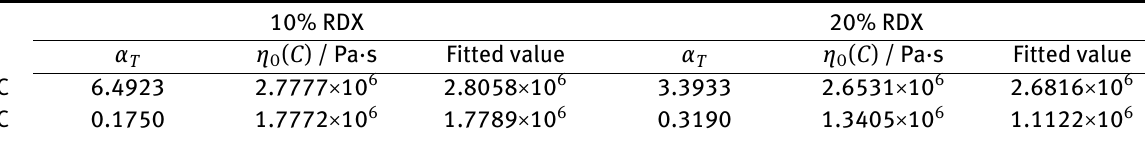
Table 12: Test value and calculated values of ZSV at different concentrations of RDX.